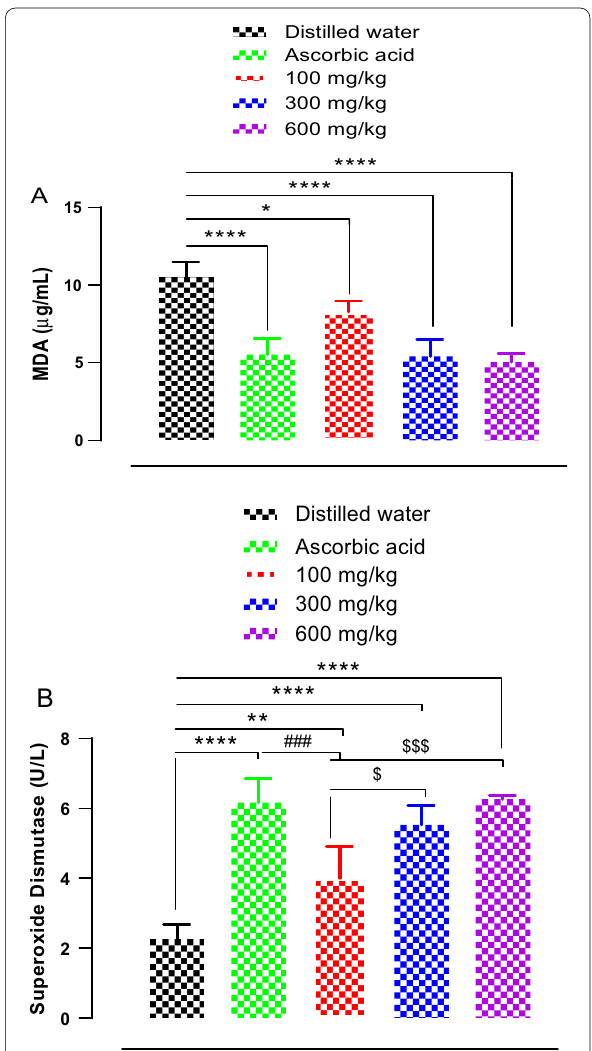
Fig. 3 Effect of METS treatment on oxidative stress measured as malondialdehyde assay (MDA) ( a ) and antioxidant enzyme superoxide dismutase (SOD) in the paw of animals exposed to CGN-induced edema ( b